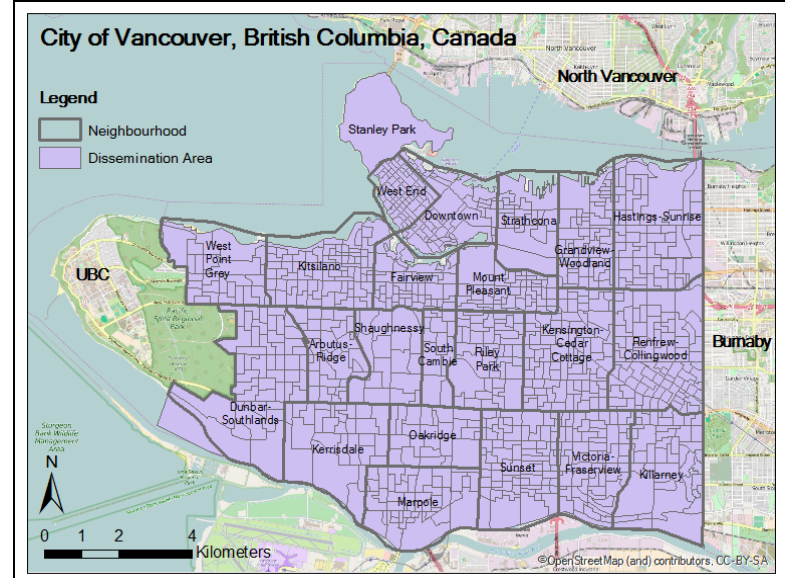
Figure 1. Study area divided into dissemination areas: City of Vancouver, British